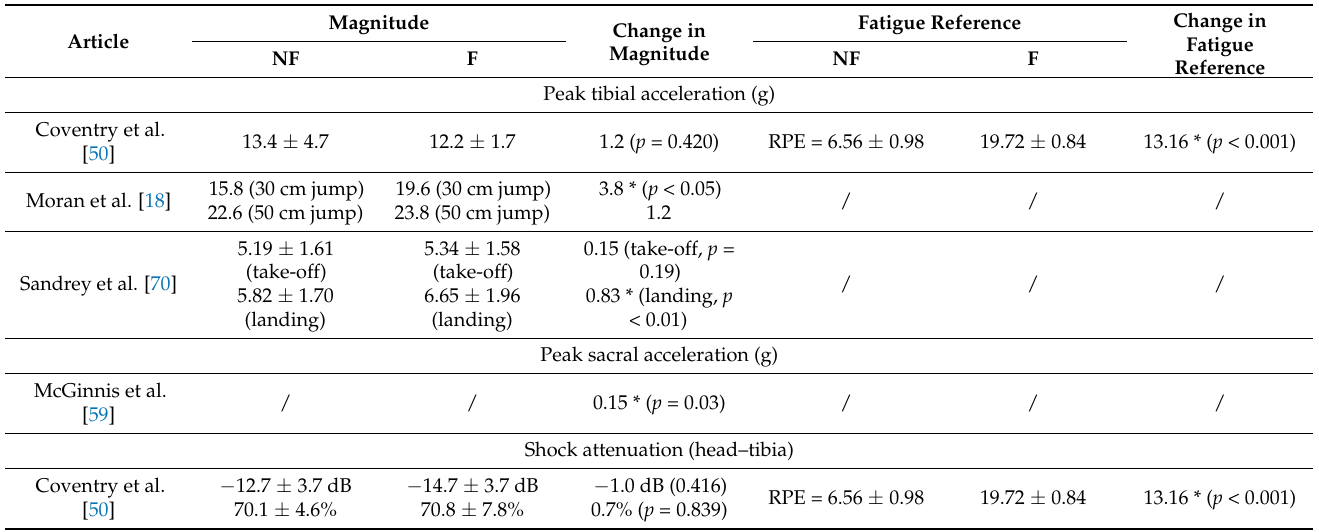
jumping jacks, and r = 0.94 for corkscrew exercises. The machine learning models used were convolutional neural networks (CNN) and random forest (RF). Table 7. Overview of biomechanical changes due to fatigue in jumping articles.